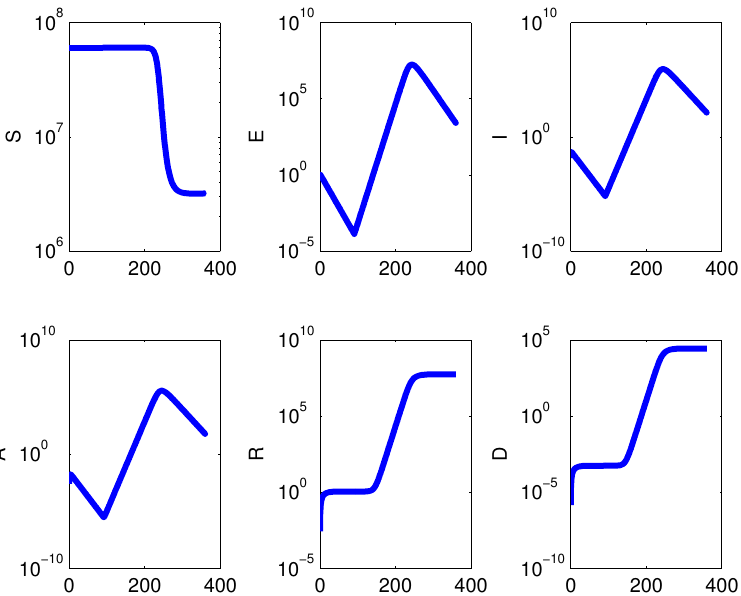
Figure 3. Using a semilogarithmic scale for the vertical axis, we show the results of starting the restrictions at time t 1 = 1, using β I = 10 − 10 and lifting them at time t 2 = 90, returning to β I = 10 − 7 three months later, over a one year timespan for the model with demographics (1). Left to right and top to bottom, the subpopulations are: S , E , I , A , R and D , the disease-related deceased